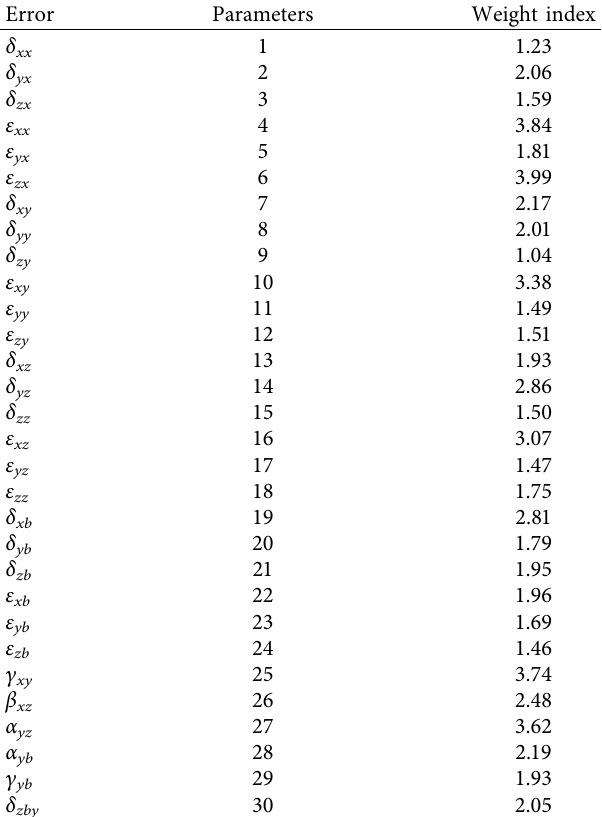
Table 5: Weight coefficients of the geometric error terms based on feature extraction.